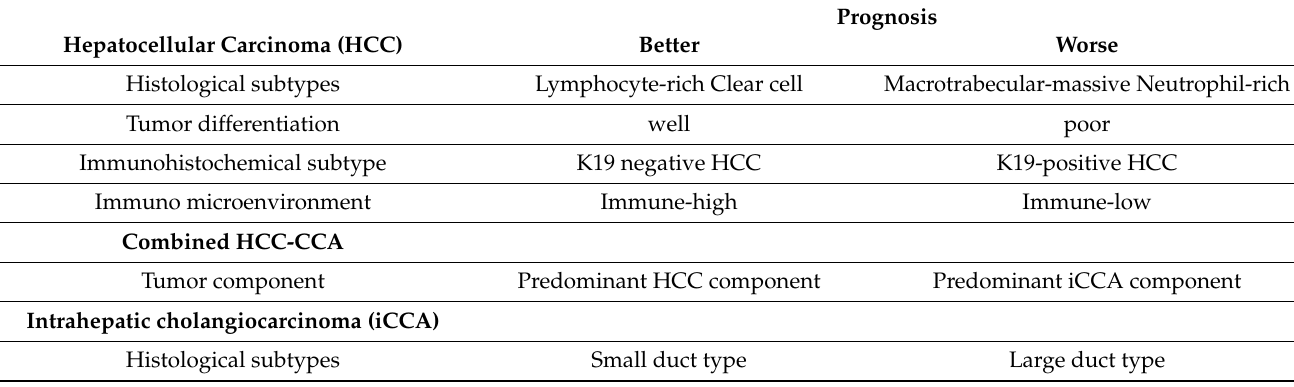
Table 1. Histological subtypes of Primary liver cancers (PLCs) and